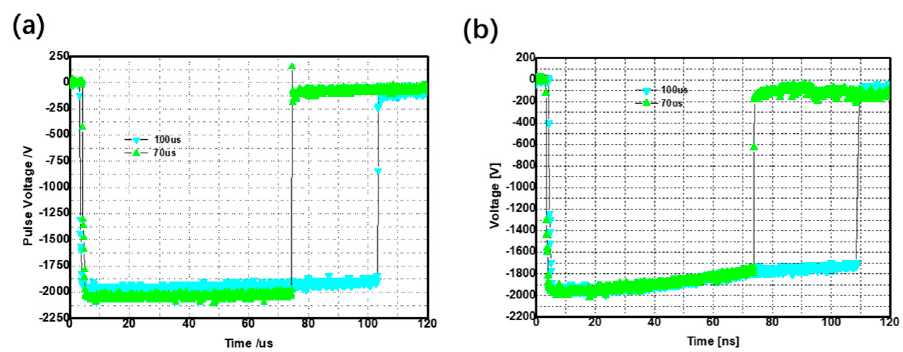
Figure 9. The voltages on the in-vitro loads with different widths in the microsecond pulse mode. ( a ) The swine tissue load; ( b ) the cell culture cuvette load.